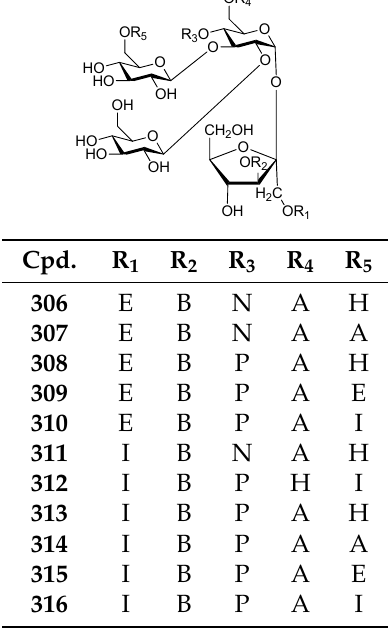
Figure 63. Structures of compounds 306 – 316 .